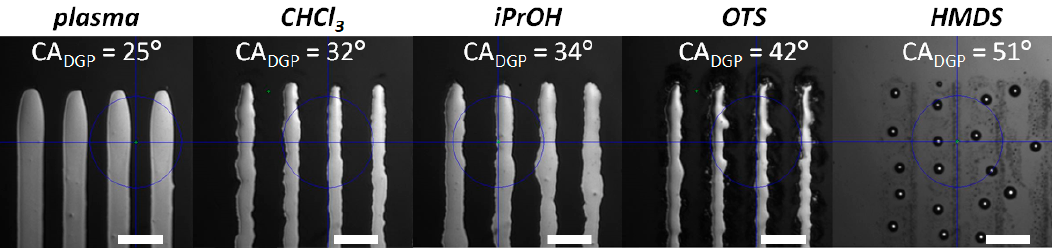
Figure 2. Optical microscope images of DGP overprints on SiO 2 surface with different types of treatment. Scale bar equal 100 μ m.